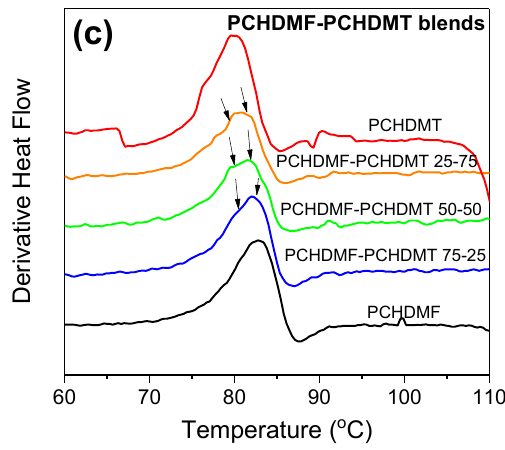
Figure 7. ( a ) DSC thermograms of neat PCHDMF, neat PCHDMT, and their respective blends, ( b ) zoomed-in area of the glass temperature, and ( c ) derivative of heat flow for all samples under study.